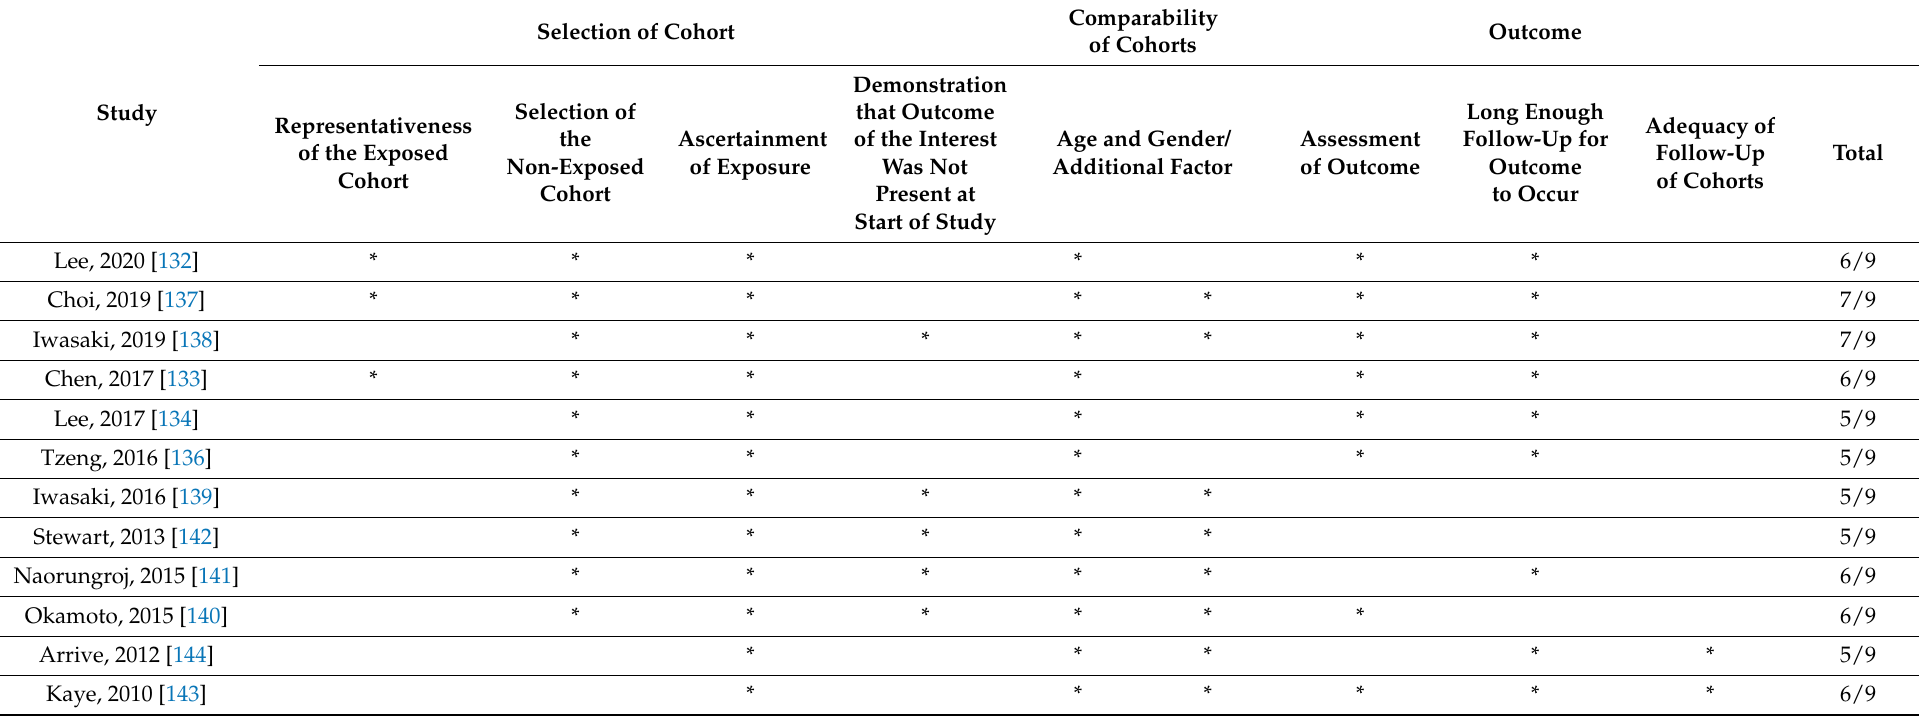
Table 4. Quality of cohort studies assessed using the Newcastle–Ottawa